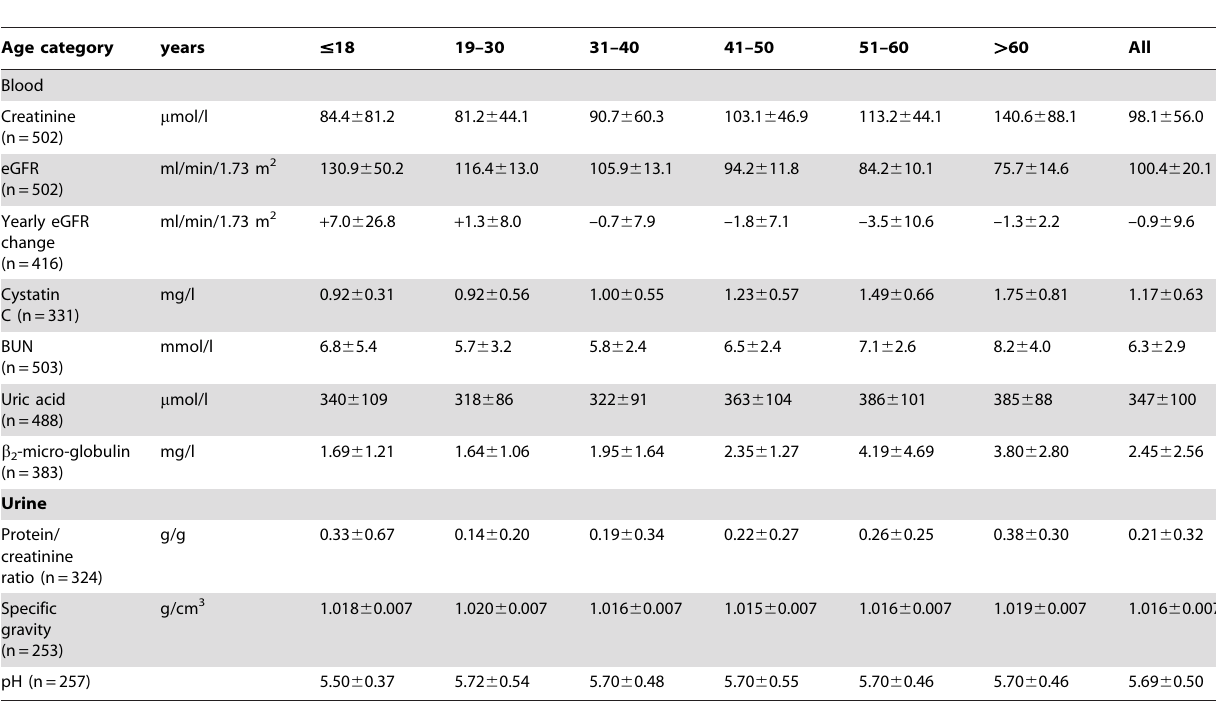
Table 2. Baseline renal parameters and eGFR data stratified by age